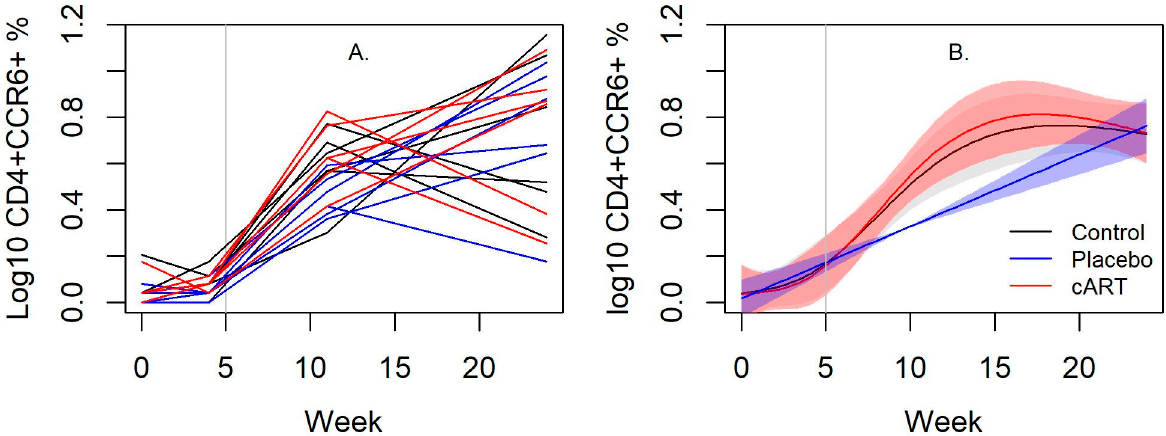
Figure 5. cART improved oral immunity in FIV infected cats. In the mandibular lymph nodes of cART-treated FIV+ cats, CD4 + CCR6 + cells were significantly higher than in placebo-treated FIV+ cats. The increase of CCR6 + lymphocytes in cART-treated FIV+ cats may illustrate a partial restoration in Th17 cells. Collectively, the results may demonstrate that cART improves mucosal immunity. The vertical bar indicates when cART and placebo treatment began. ( A ) A line plot of individual cats over time and ( B ) its associated spline fit from GAM analyses are presented.